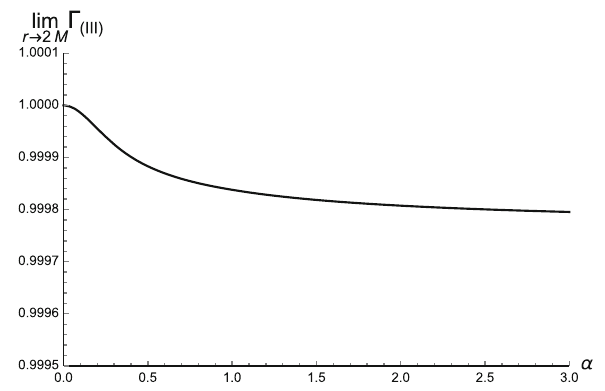
Fig. 3 Plot of lim r → 2 M Γ (III) as a function of the decoupling parameter